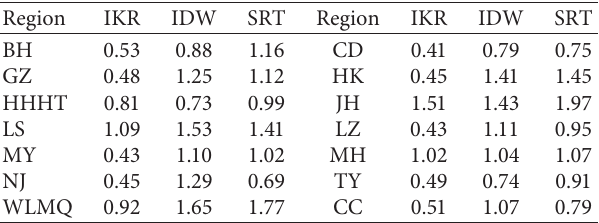
Table 2: The best QC parameters of the three algorithms in the 14 regions of the country.